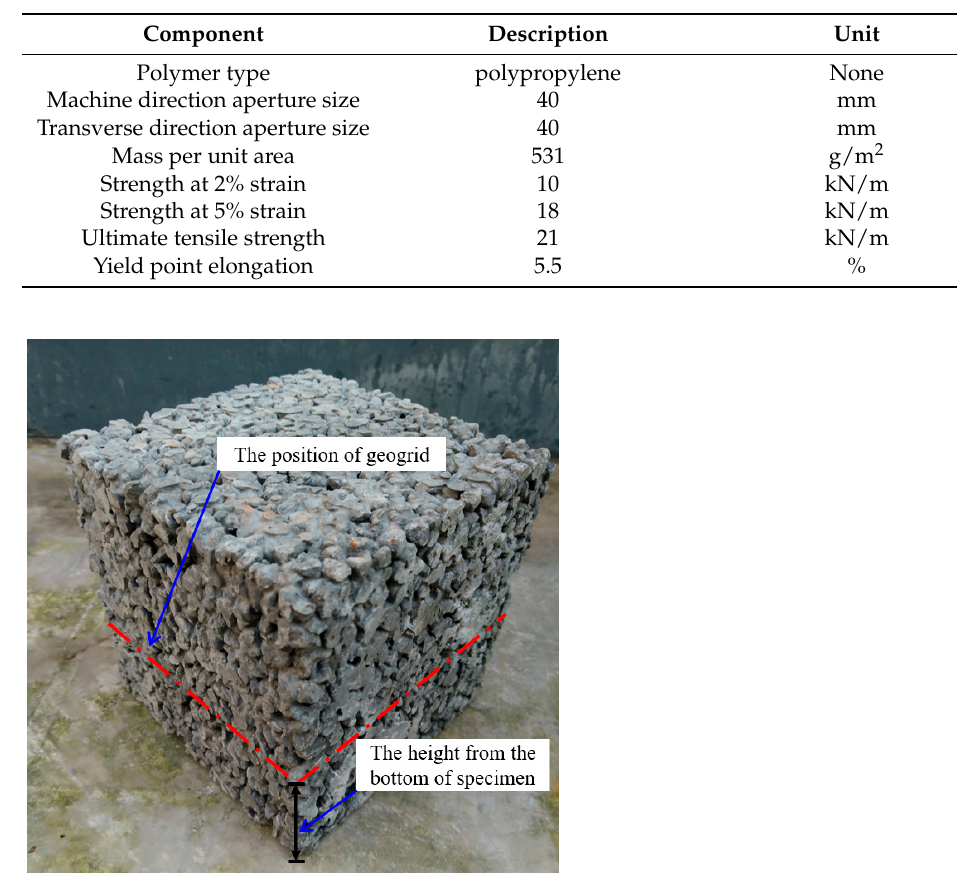
Figure 2. Biaxial geogrid. Table 2. Physical and mechanical properties of the biaxial geogrid.